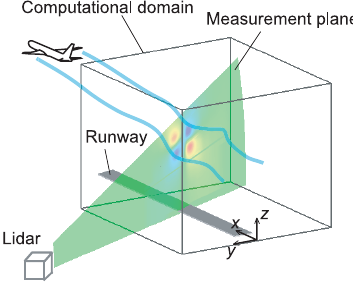
Fig. 1 Schematic of lidar measurement plane and computational